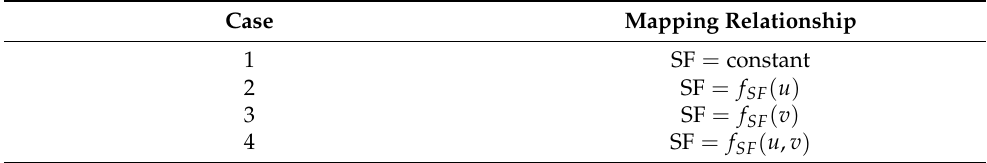
Table 1. Summary of the mapping relationship cases between the SF and the operating condition.